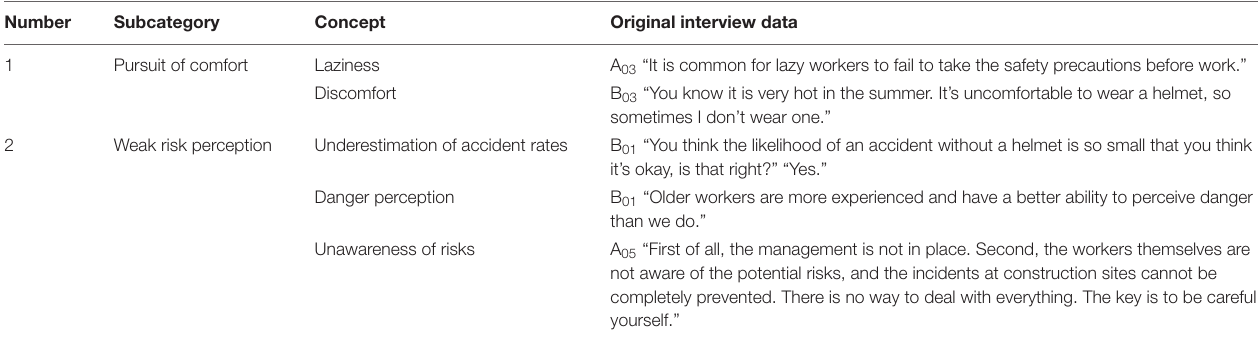
TABLE 2 | Subcategories and concepts developed from original interview data through open coding (excerpted sample).